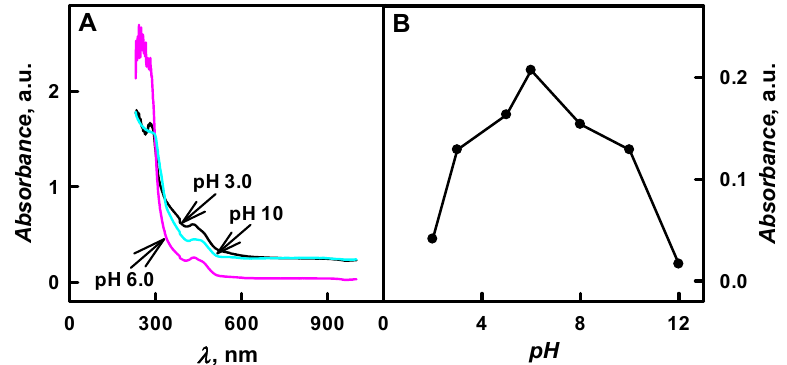
Figure 3. ( A ) The spectra of formed Ppy/GOx composite nanoparticles colloidal solution at various solution pH values and ( B ) dependence of optical absorbance at λ max = 460 nm on the solution pH. (The composition of polymerization solution: 0.05 mol L − 1 of glucose, 0.50 mol L − 1 of pyrrole, and 0.75 mg mL − 1 of glucose oxidase at pH 2.0–12; 48 h lasting polymerization was performed. Optical absorbance was registered in 0.05 mol L − 1 SA buffer, pH 6.0).